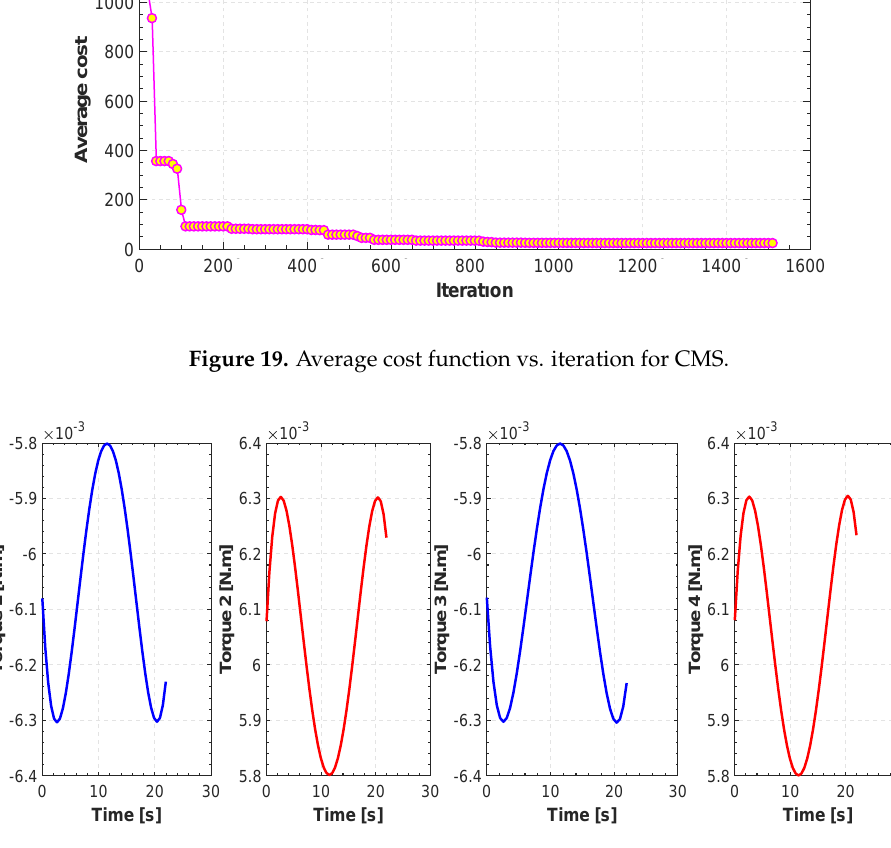
Figure 20. Evolution of actuator torques for